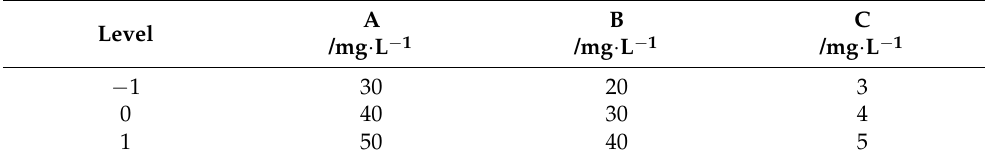
Table 2. The test factors and